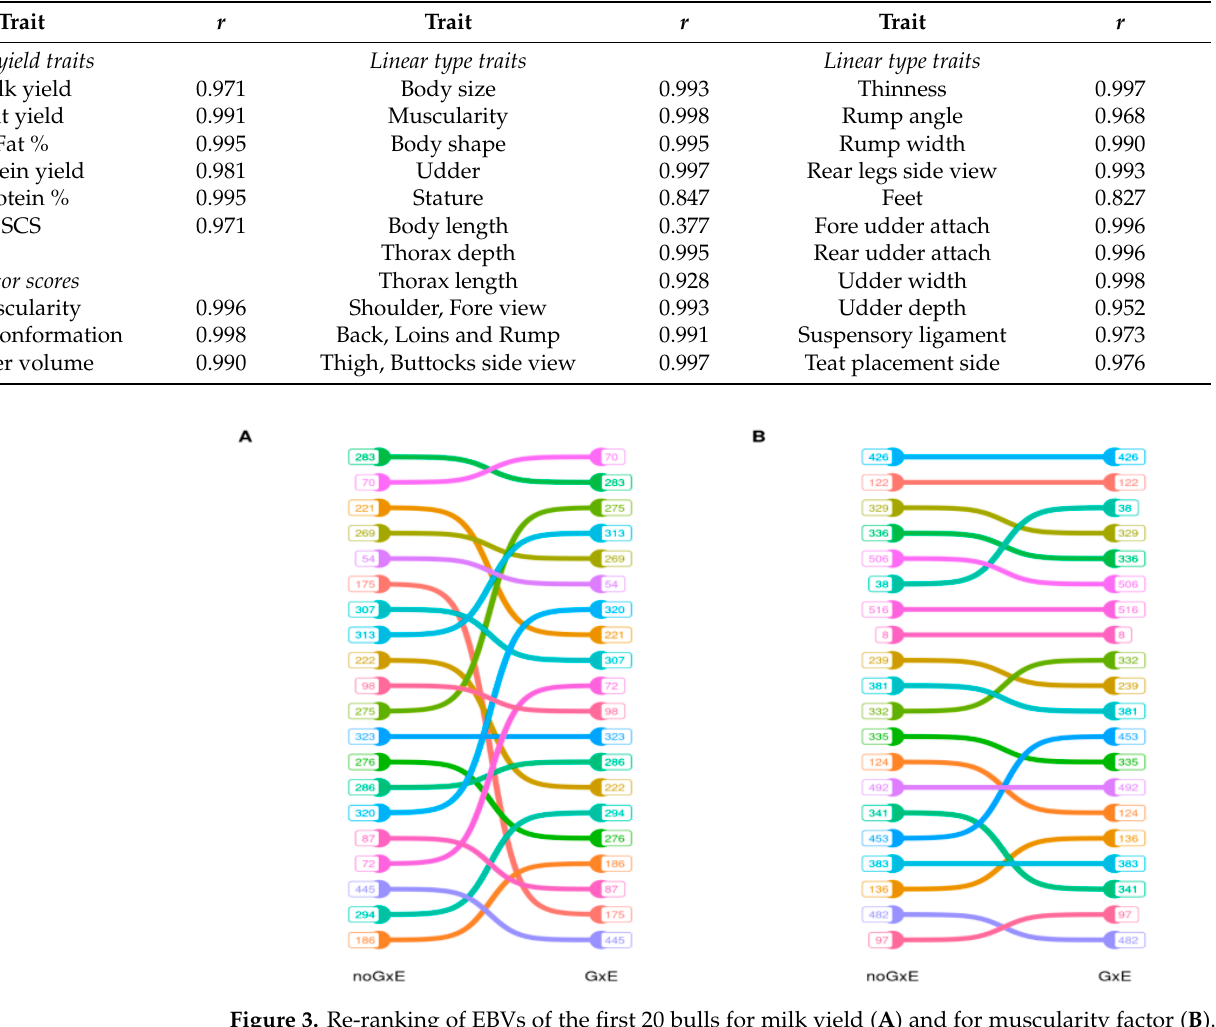
Figure 3. Re-ranking of EBVs of the first 20 bulls for milk yield ( A ) and for muscularity factor ( B ). The EBVs have been obtained from the reaction norm model not including GxE (labelled noGxE in figure) vs. the reaction model including GxE.